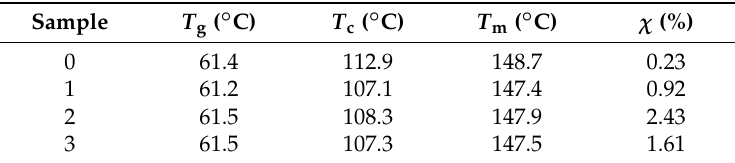
Table 4. Thermal characteristics of pure PLA and PLA/melanin